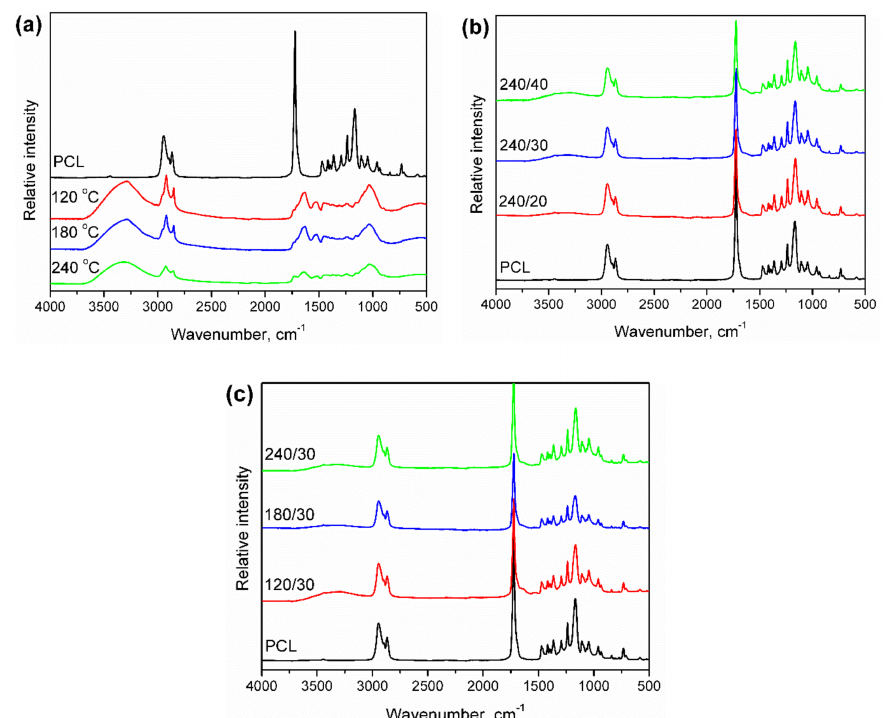
Figure 6. FTIR spectra of poly( ε -caprolactone) (PCL) and ( a ) modified BSG samples, ( b ) composites filled with varying content of BSG modified at 240 ◦ C, and ( c ) composites filled with 30 wt% BSG modified at di ff erent